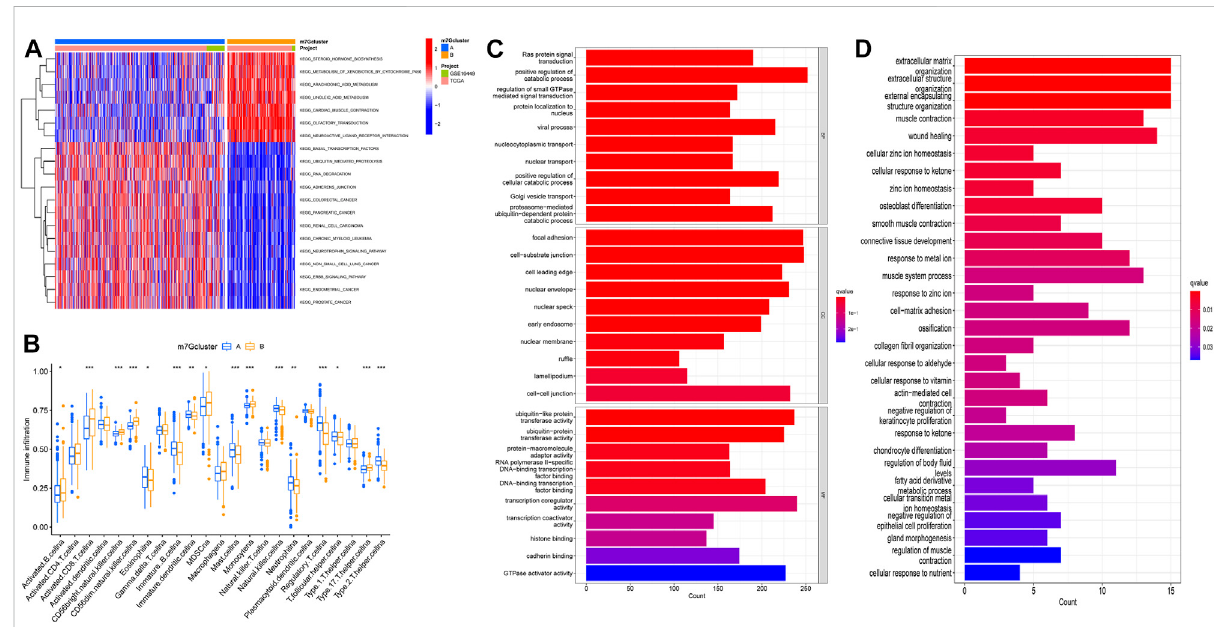
FIGURE 3 M7G subtype enrichment analysis. (A) GSVA enrichment analysis of different subtypes, blue and red represented inhibition and activation pathways, respectively. (B) Difference in immune in fi ltration of m7G subtypes. (C,D) GO and KEGG enrichment analysis. GSVA, gene set variation analysis; GO, Gene Ontology; KEGG, Kyoto Encyclopedia of Genes and